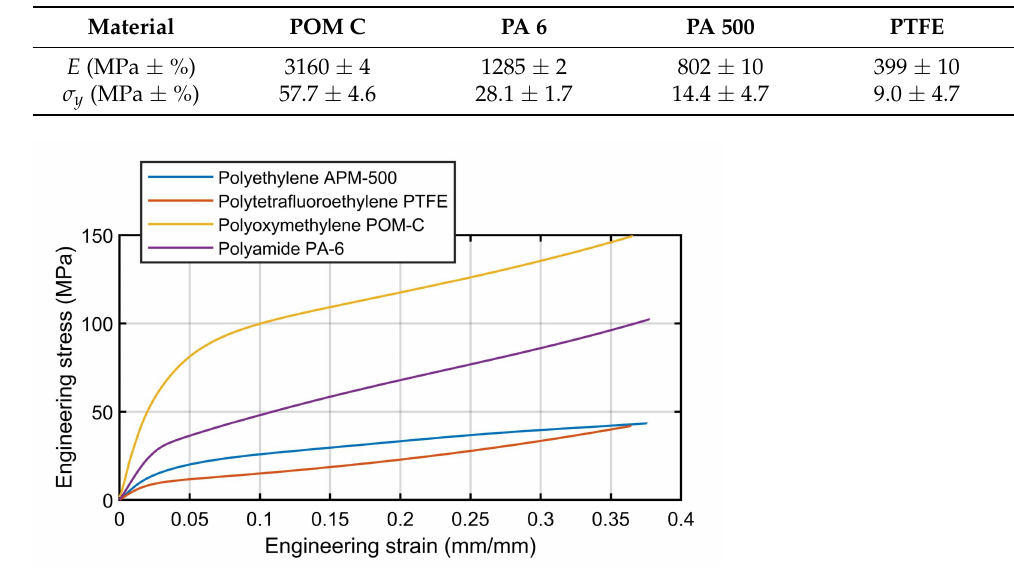
Figure 6. Stress vs. strain curves of the compression